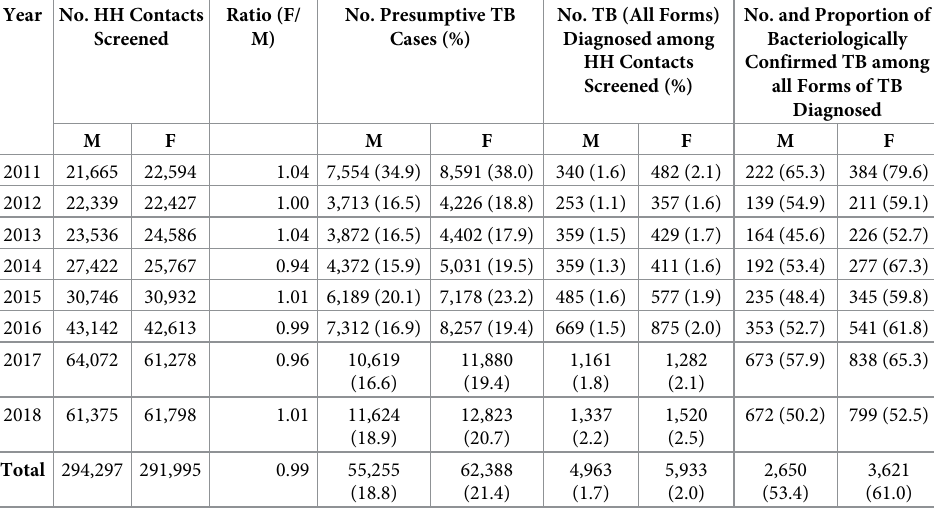
Table 2. Yield of screening of household contacts of TB index cases by sex.